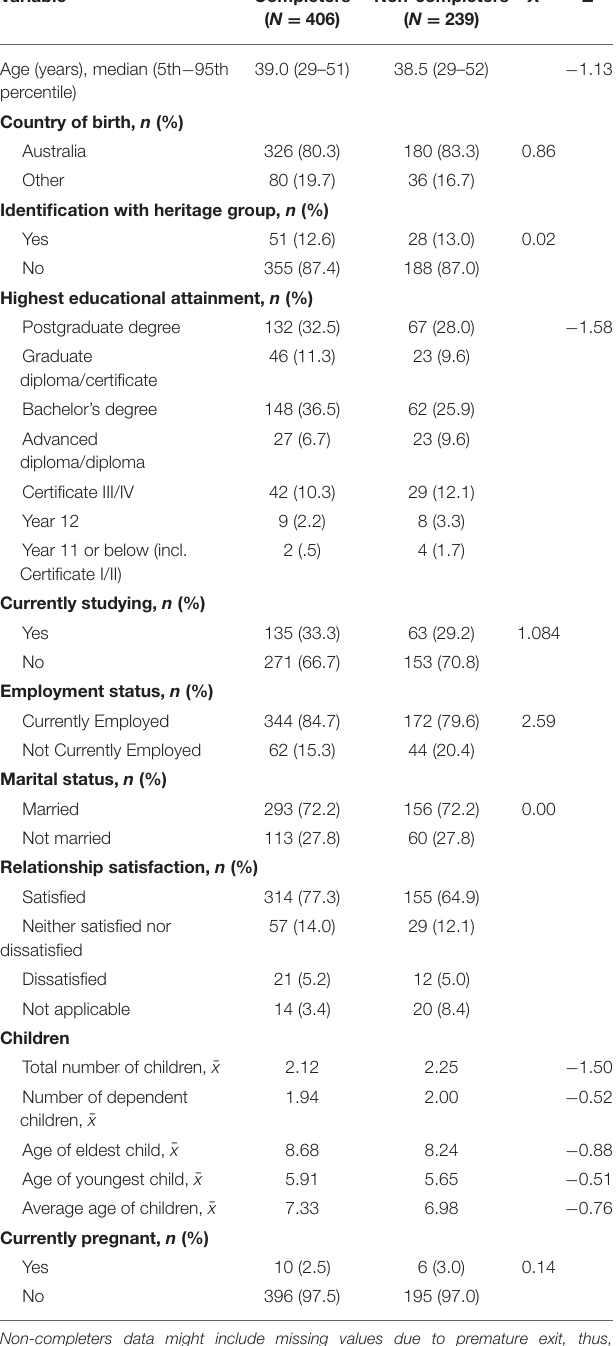
TABLE 1 | Demographic characteristics of eligible survey completers vs. non-completers.